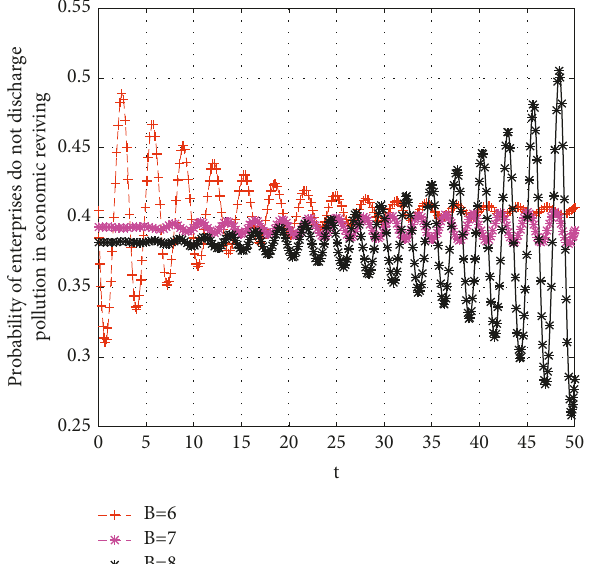
Figure 11: The evolution path of enterprises’ nondischarge when increasing the incentives under the dynamic incentives mechanism and penalties mechanism.